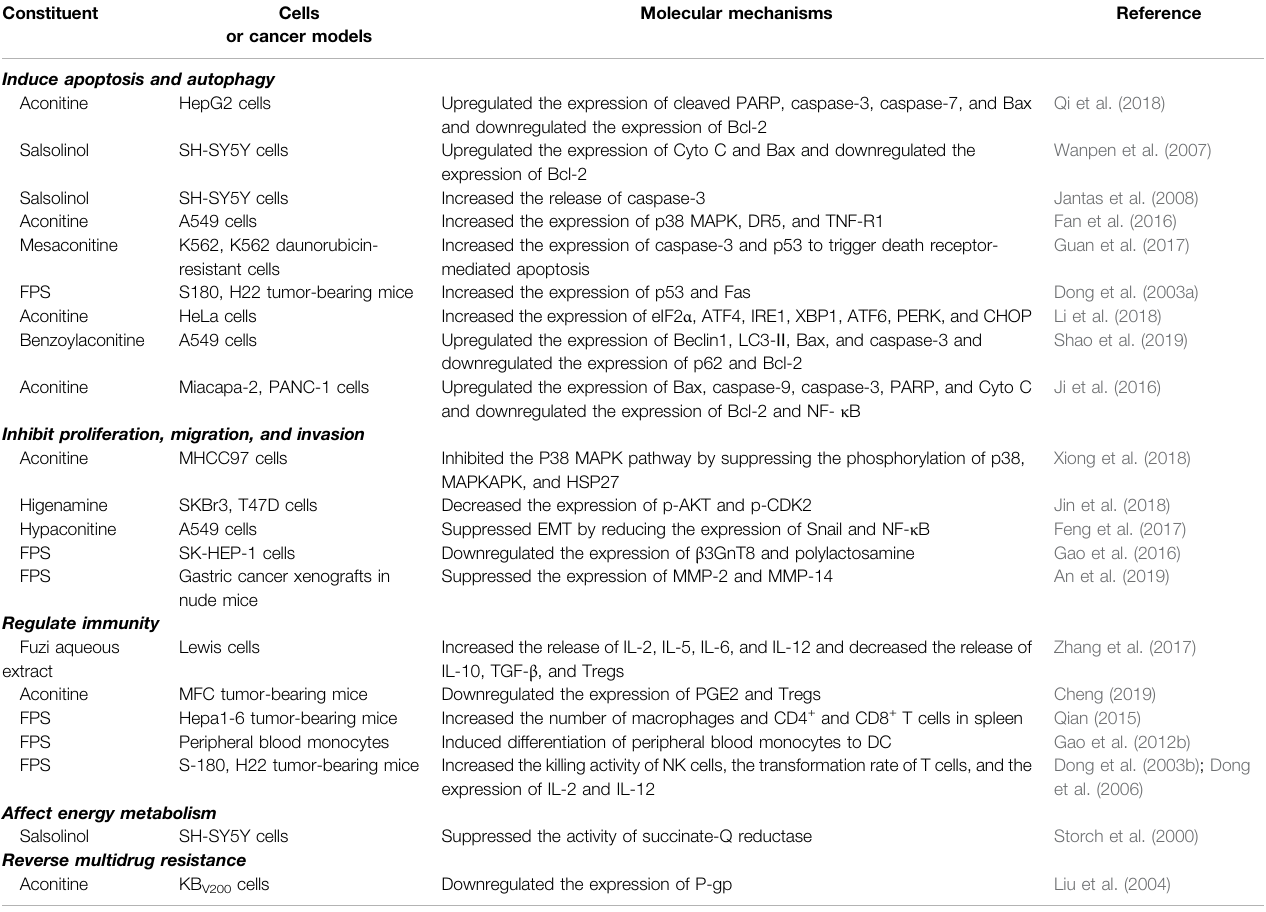
TABLE 4 | Anticancer constituents of Fuzi and relevant